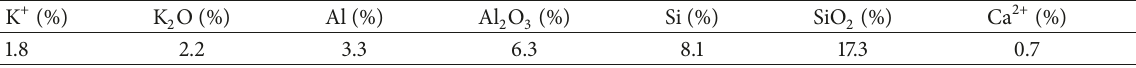
Table 2: Chemical composition of Al-Qatif clay.